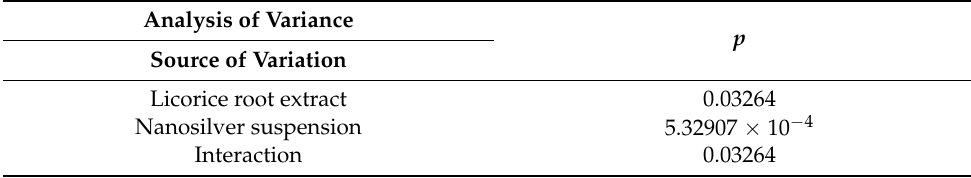
Figure 12. Results of in vitro cytotoxicity analysis of hydrogels via the MTT reduction assay. Table 5. Results of the statistical analysis of MTT reduction assay conducted via the two-way analysis of variance (ANOVA) ( p indicates the statistical significance).